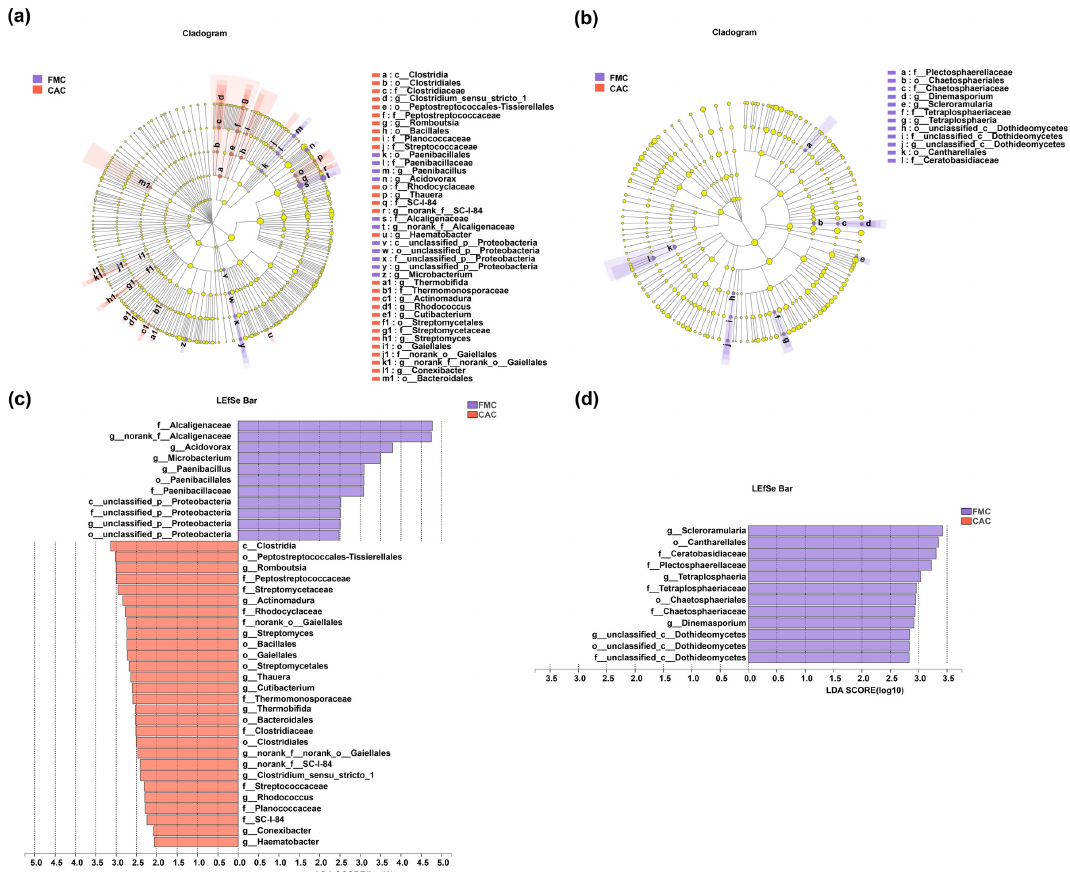
Figure 4. Cladogram showing the phylogenetic distribution of the bacterial ( a ) and fungal ( b ) lineages associated with stems of sugarcane under FMC and CAC treatments. Indicator bacteria ( c ) and fungi ( d ) with LDA scores of 2.0 or greater in microbial communities associated with stems of sugarcane under FMC and CAC treatments (LEfSe). Circles indicate phylogenetic levels from phylum to genus. The diameter of each circle is proportional to the abundance of the group. Different prefixes indicate different levels (p—phylum; c—class; o—order; f—family; g—genus). FMC—fully mechanized cultivation; CAC—conventional artificial cultivation.